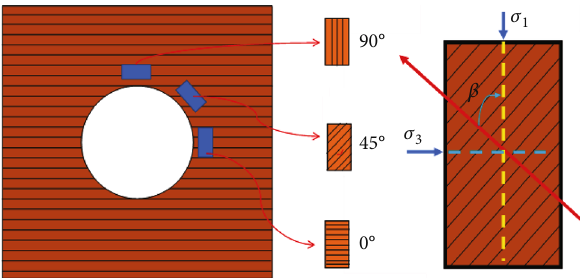
Figure 1: Schematic showing orientation of near-wellbore stress concentrations for horizontal well with respect to bedding orientations in layered formation